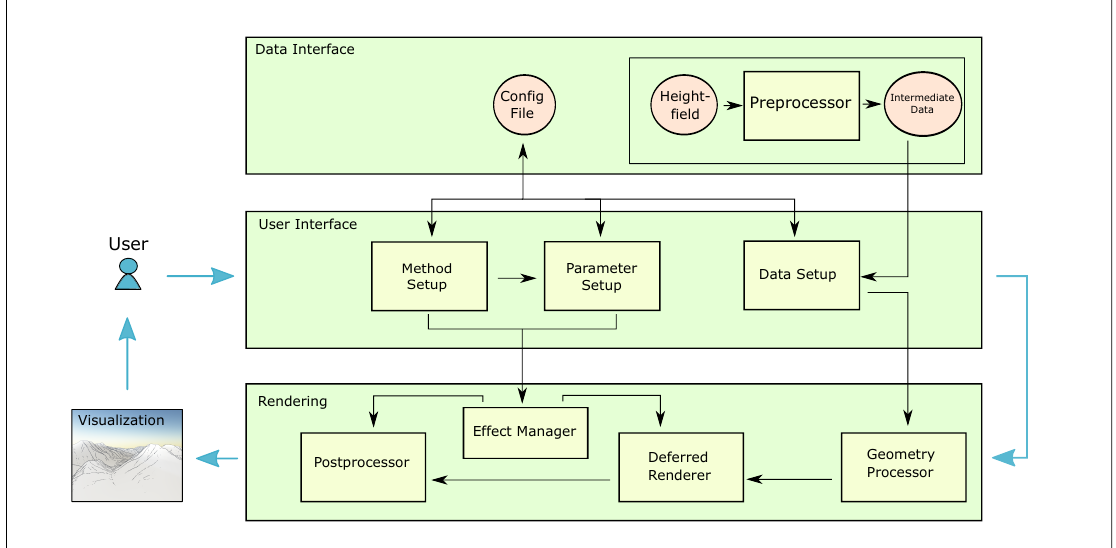
Figure 15. Overview of the architecture of T EDA V IS